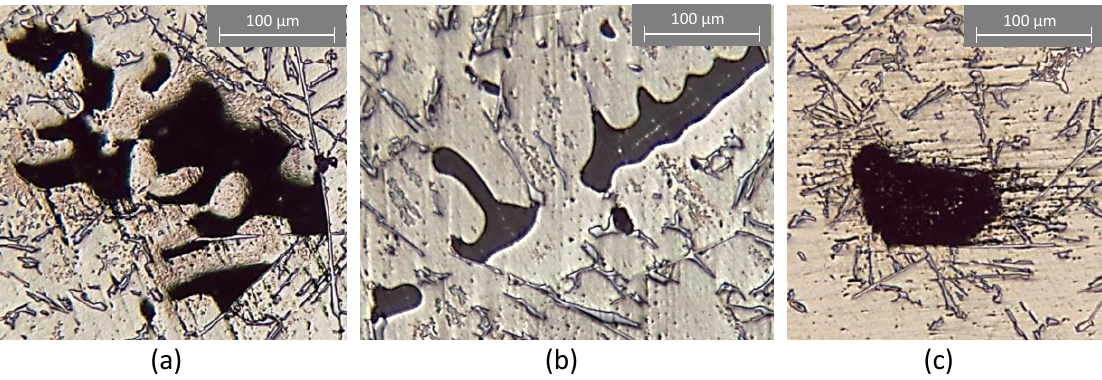
Figure 14. Di ff erent types of pores found in all samples. ( a ) Pores associated with shrinkage, ( b ) pores associated with shrinkage and gas entrapment and ( c ) pores associated with gas entrapment.